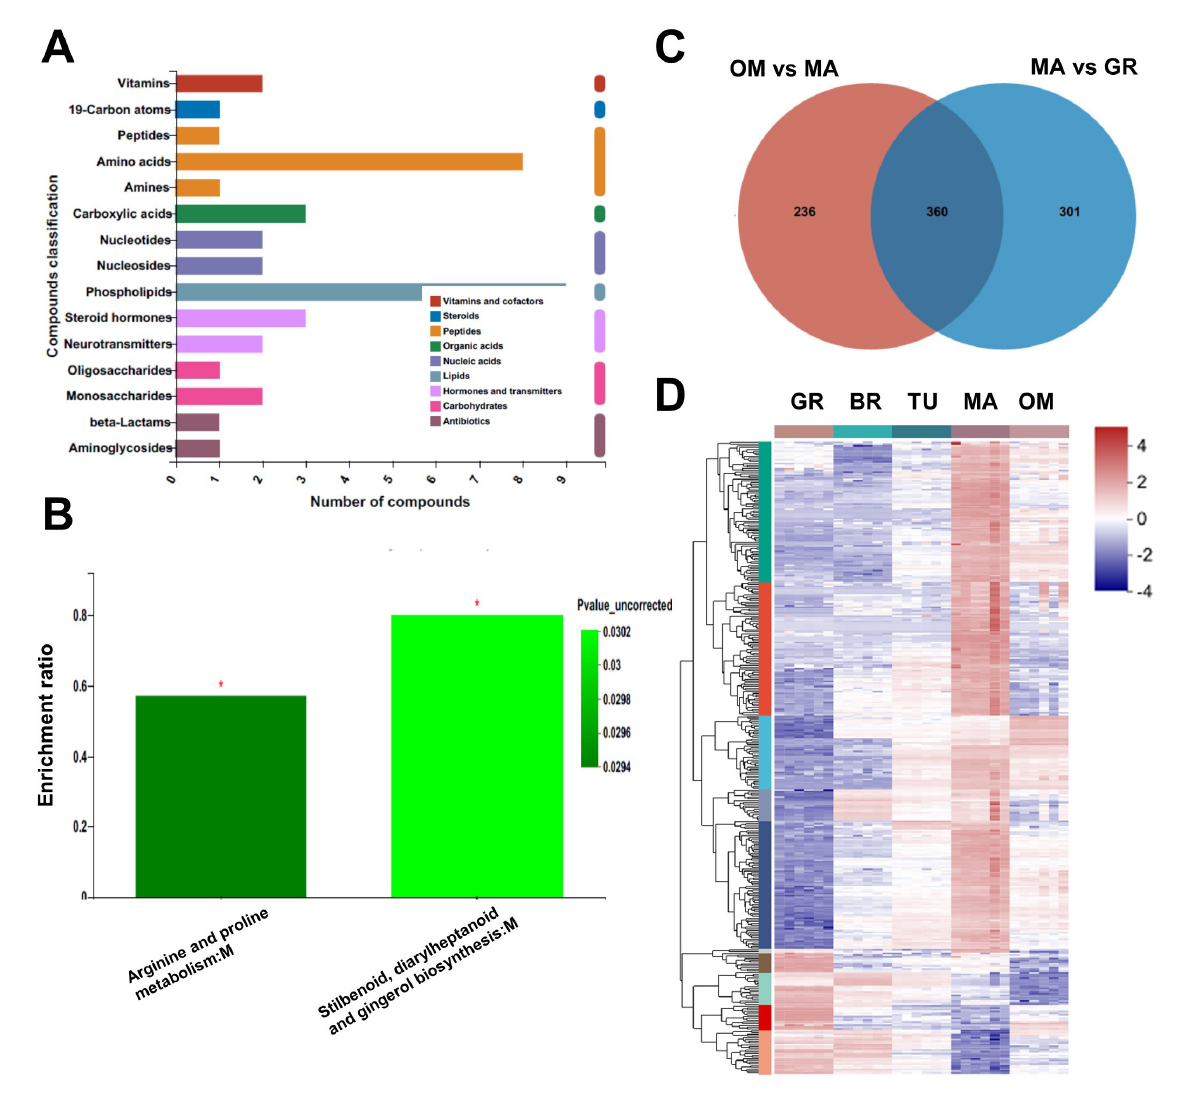
Figure 5. Metabolites changes during fruit over ‐ maturing. KEGG compound classification ( A ) and KEGG analysis ( B ) of OM ‐ changed metabolites. Venn diagram of the intersection of MA ‐ changed and OM ‐ changed metabolites, * p < 0.05; ( C ). The relative abundance of metabolites in the intersection of MA ‐ changed and OM ‐ changed metabolites ( D ). The original abundance was subjected to data adjustment by normalization using an R package. GR, Green ripe; BR, Break; TU, Turning; MA, Mature; OM, Over ‐ mature.